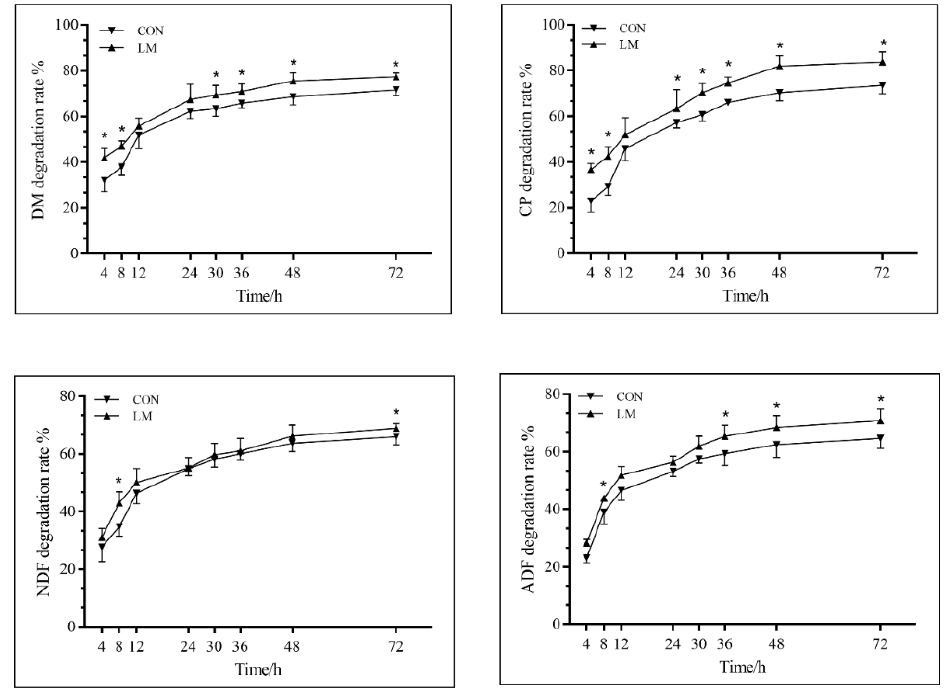
Figure 1. The rumen in situ real-time degradation rates of PM silage DM, CP, NDF, and ADF. The * denotes p < 0.05 between the two groups compared; values are expressed as the mean ± SE; DM, dry matter; CP, crude protein; NDF, neutral detergent fiber assayed with a heat stable amylase and expressed inclusive of residual ash; ADF, acid detergent fiber expressed (inclusive of residual ash); CON, no additive group; LM, lactic acid bacteria and molasses group.